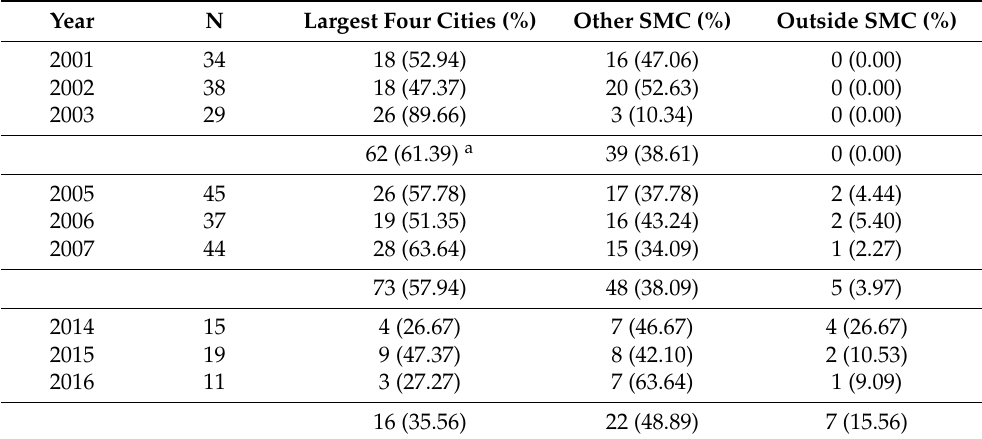
Table 6. Feline immunodeficiency virus positive prevalence, stratified by source location within San Mateo County, among feral cats presented to the PHS Spay/Neuter Clinic in the years 2001–2003, 2005–2007, and 2014–2016